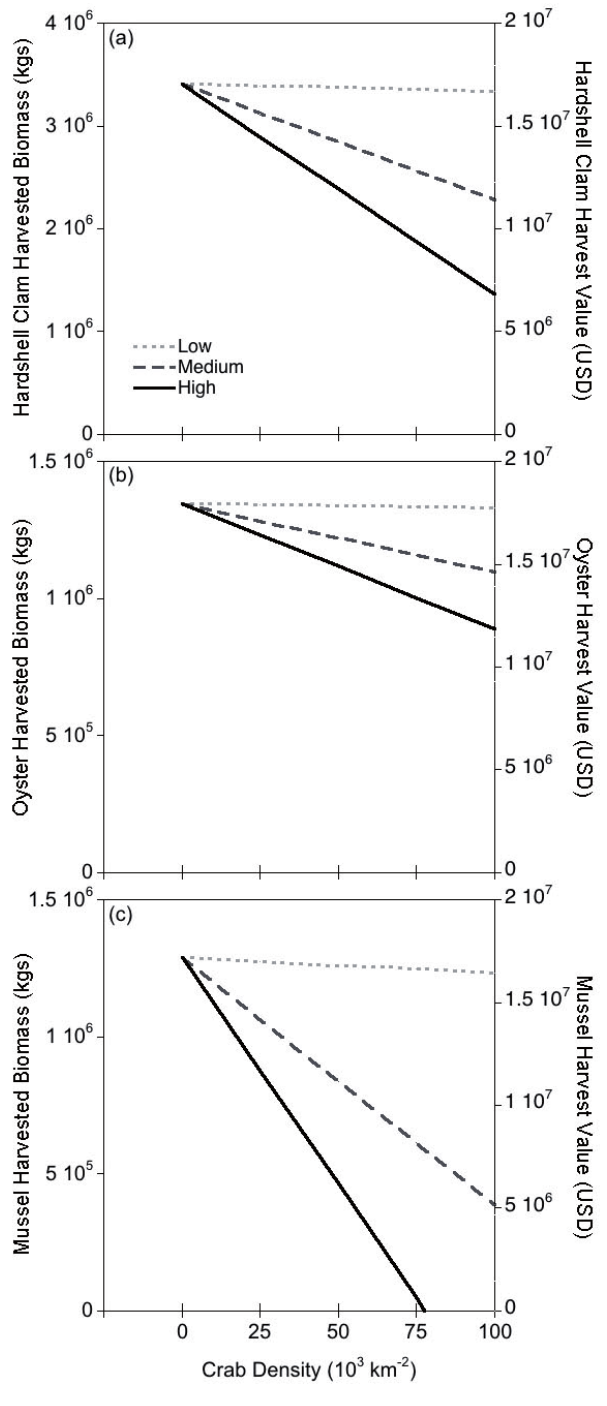
Figure 3. Loss of shellfish biomass and revenue at increasing densities of green crab. Mean harvested shellfish biomass (kg) and revenue (USD) at increasing levels of green crab densities for three shellfish species groups: a ) hardshell clams, b ) oysters, c ) mussels at three increasing levels (dotted light grey, low; dark grey dashes, medium; black solid line, high) of calories consumed by each green crab year -1 .